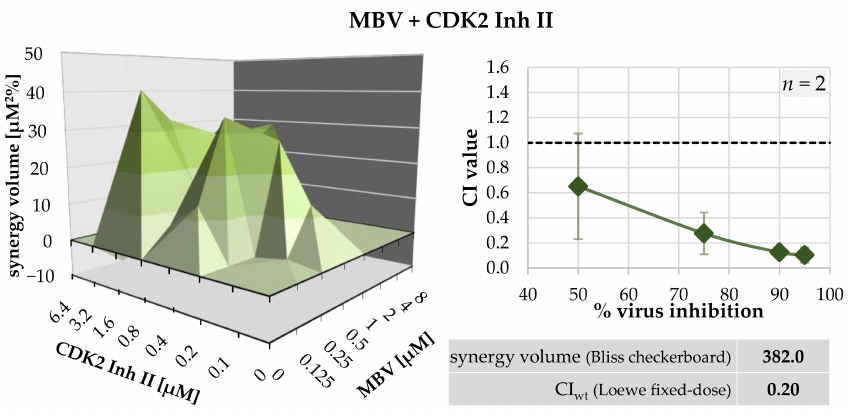
Figure 2. Depiction of a synergistic interaction between MBV + CDK2 Inh II, representing a pair of virus- and host-directed PKIs. Evaluation was performed using the Bliss independence checkerboard assay (left) and Loewe additivity fixed-dose assay (right). The inserted table shaded in grey gives the sum of positive and negative 95% confidence interval SV [ µ M 2 %] as well as CI wt (see Tables 5 and 6 for detailed